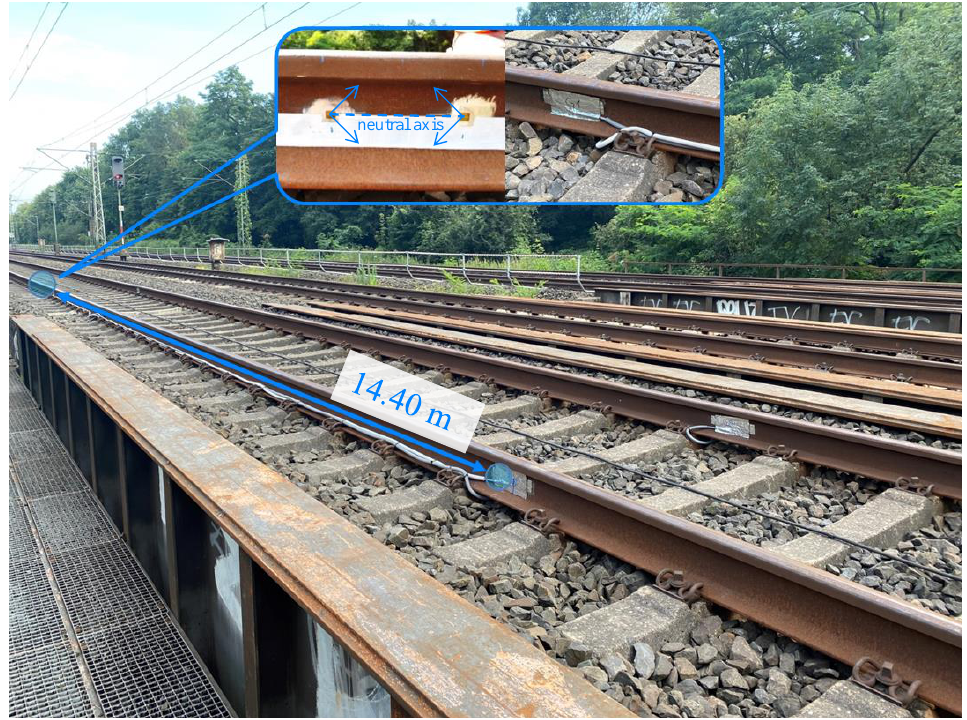
Figure 4. Top view of the bridge with the wheel load measuring points used at a distance of 14.4 m, with a detailed view of the rosette strain gauges and the weatherproof measuring point installed.